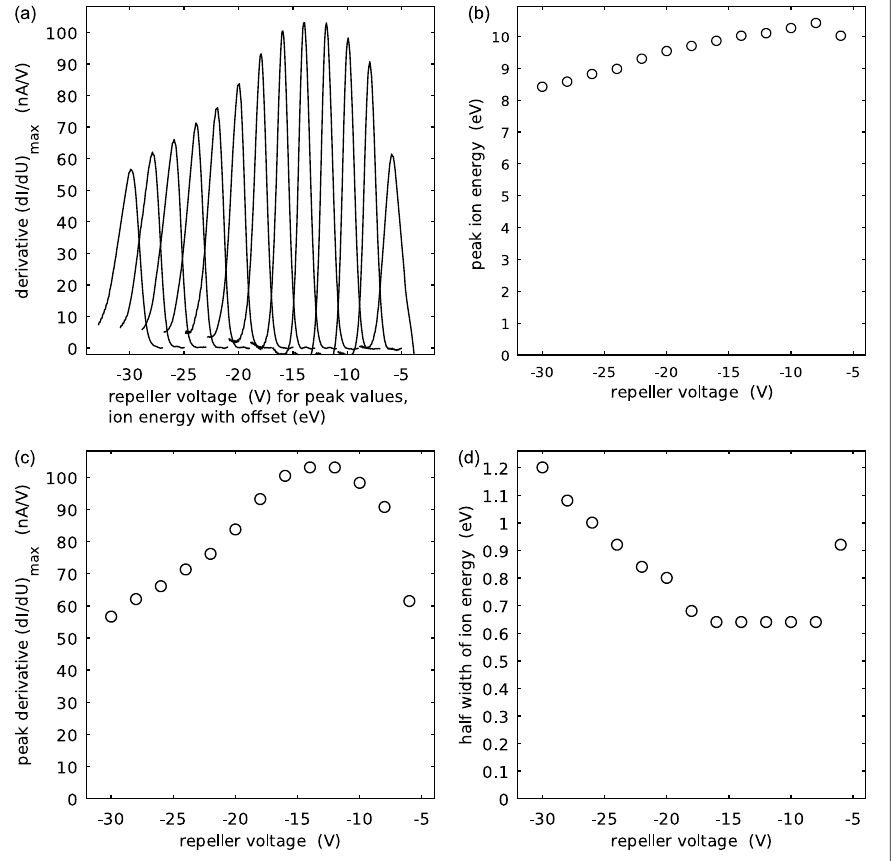
Fig. 10 Variation of the RPA repeller grid voltage from -30V to -5V in steps of 1V. These measurements were performed in the HIBEX test chamber equipped with the gridded ion source. The a hot filament cathode had a potential of − 35V. (a) Synopsis of all IEDFs. The IEDFs are horizontally shifted so that their peak values indicate the respective repeller voltage on the abscissa. (b) The peak of the measured IEDFs slightly depends on the chosen repeller voltage. (c) The height of the peak values of the IEDF reaches highest values for repeller voltages ( − 14 ± 2 ) V. (d) The distribution functions appear sharpest for repeller voltages >